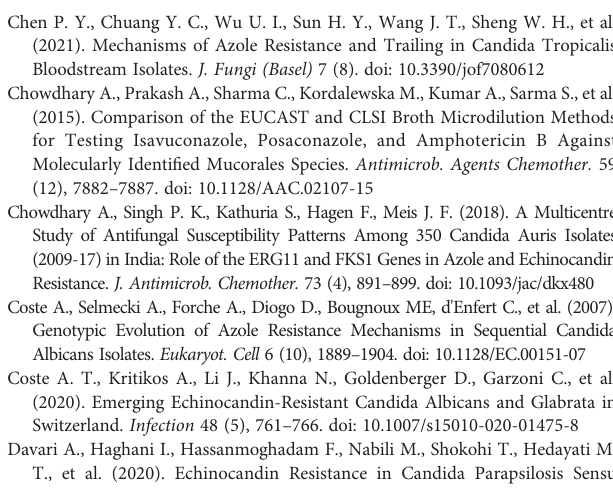
Supplementary Figure 1 | Confusion matrix of MIC categories for C. albicans and C. glabrata . (A) Comparison of YO versus MNV using breakpoints for C. albicans , (B) Comparison of YO versus MNV using ECV/ECOFF for C. albicans , (C) Comparison of YO versus MNV using breakpoints for C. glabrata , (D) Comparison of YO versus MNV using ECV/ECOFF for C. glabrata . VME: Very Major Error in red, ME: Major Error in orange, mE: Minor error in yellow, no errors in green and no analysis (NA) in grey. For each category of discrepancies, the number of event is indicated (n = xx) with the percent of possible comparisons it represents. Supplementary Table 1 | List of the strains used in this study. Supplementary Table 2 | Summary of the breakpoints and ECV/ECOFF available in CLSI and EUCAST consortia. Supplementary Table 3 | YO vs MNV comparisons